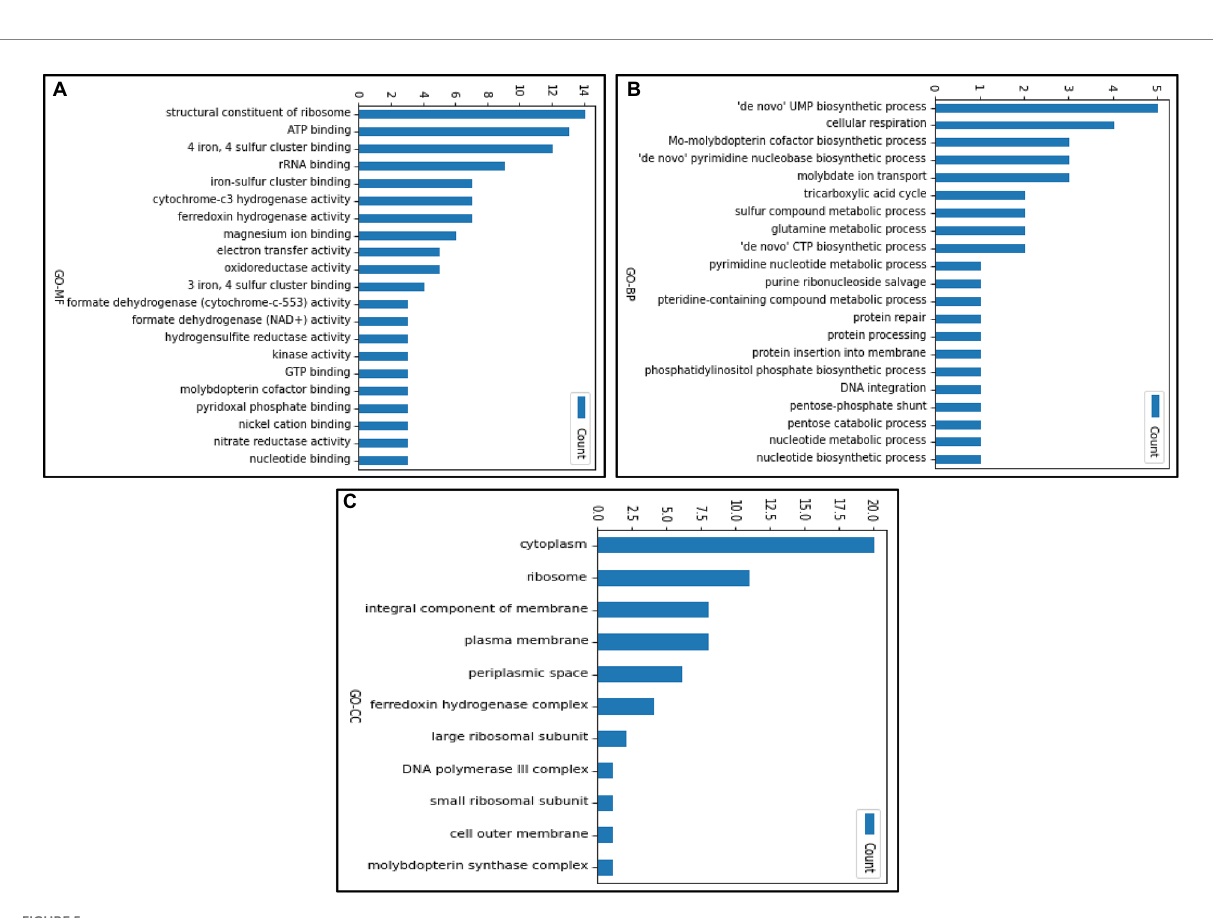
FIGURE 5 Gene count representing the individual GO terms in (A) molecular function (B) biological process (C) cellular